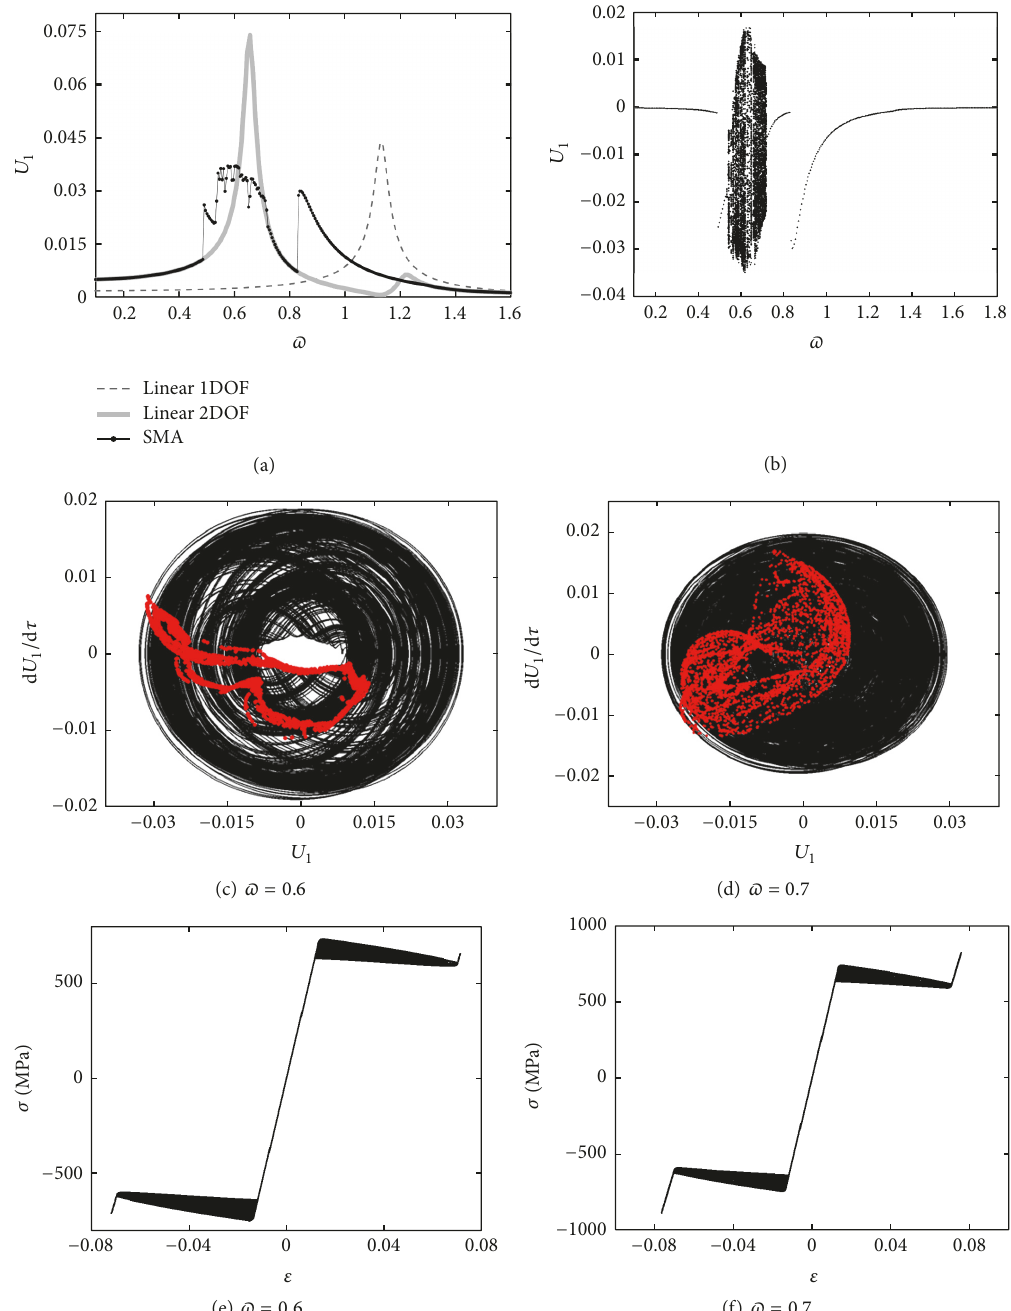
Figure 9: Primary system response with 𝛿 = 0.0025 and 𝛾 𝑚 = 0.1 in down-seep test: (a) maximum amplitude; (b) bifurcation diagram; (c-d) phase space with Poincar´e section; (e-f) stress-strain